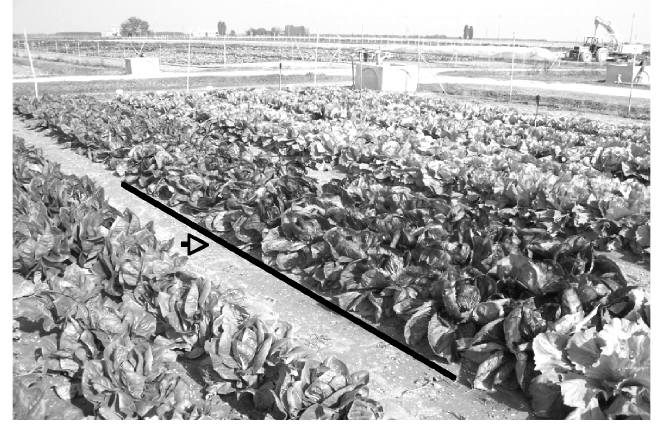
Fig. 2 - Experimental field, the arrow indicates the plot with cryopre- served ‘Rosso di Chioggia’ plants.